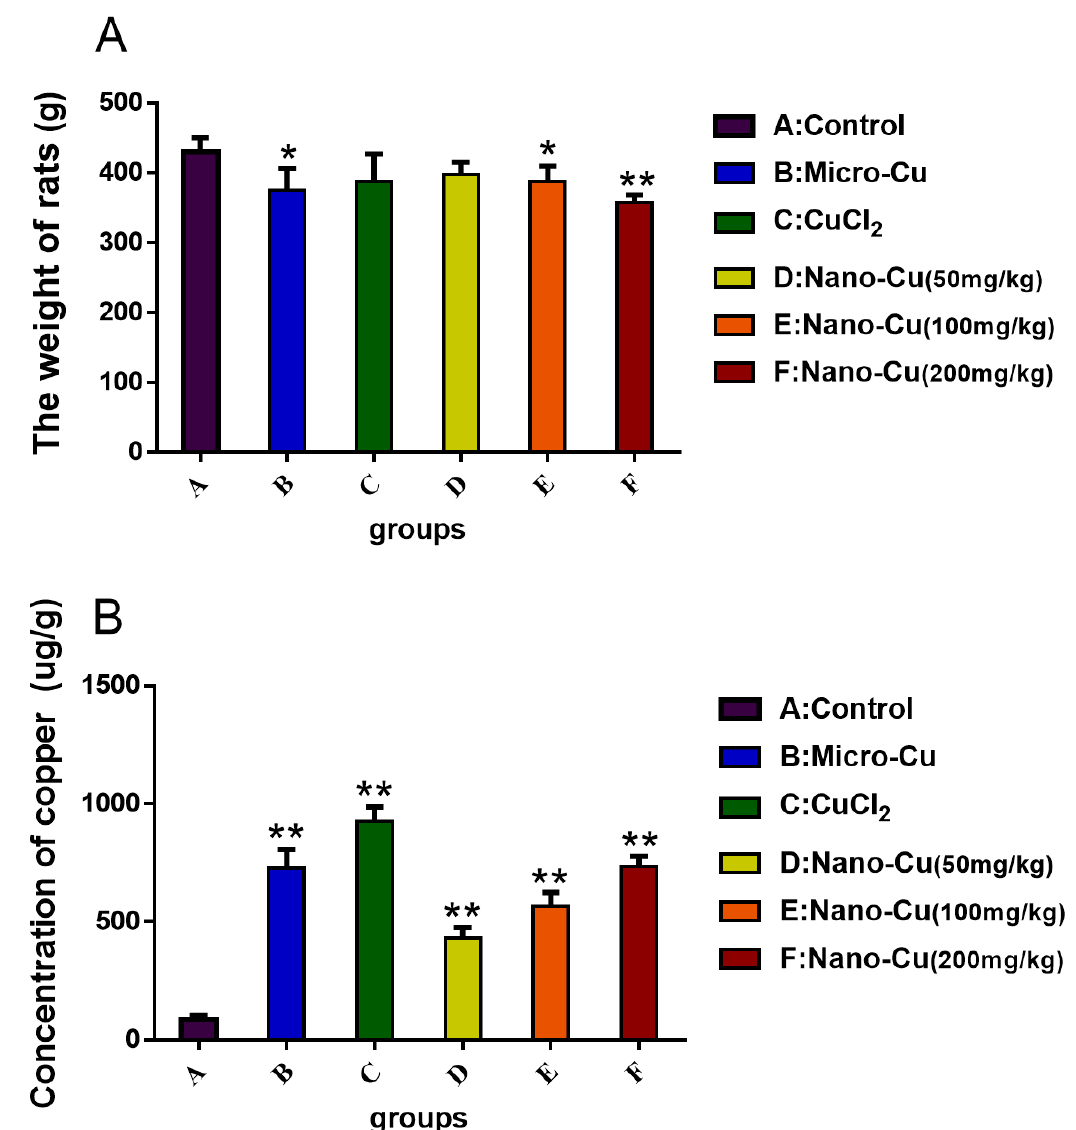
Figure 2. Weight of rats ( A ) and the concentration of copper ion ( B ) and in the spleen of each group of rats treated with oral administration of copper-containing preparations for 28 consecutive days. *